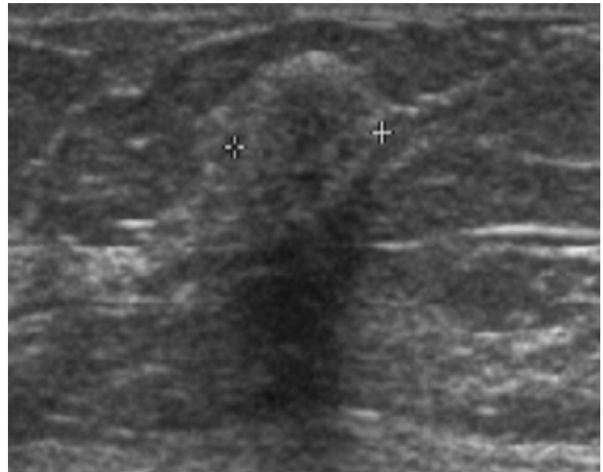
Fig. 4 Myofibroblastoma. Ultrasound scan showing a slightly heterogeneous, hyperechoic and attenuating rounded